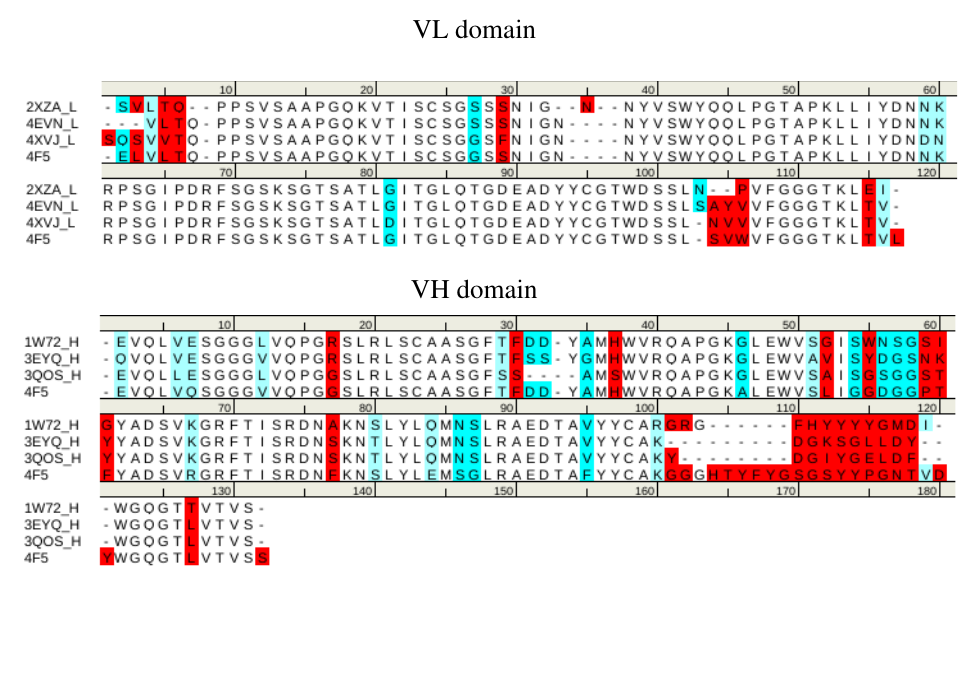
the epitopes predicted for H3N2 ( orange ) and H5N1 ( green ). The overlay regions between two subtypes are underlined in purple. Figures were prepared using PyMOL [44].